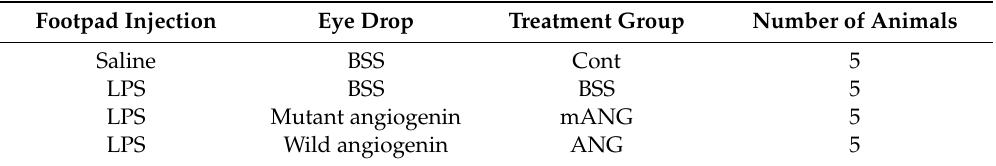
Table 1. Summary of the treatment